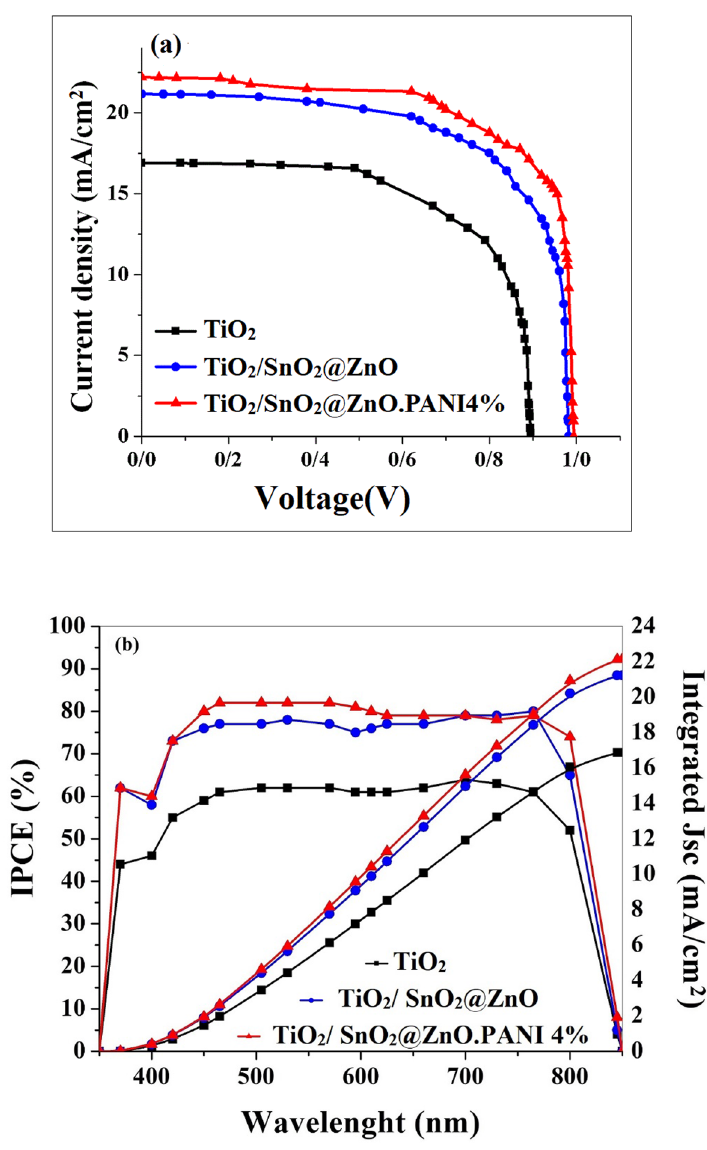
Figure 14. ( a ) The J–V tests of the PSCs from TiO 2 /SnO 2 @ZnO.PANI 4% nanocomposite, TiO 2 /SnO 2 @ZnO/ nanocomposite, and TiO 2 as ETL, and ( b ) The IPCE spectra of different PSCs based on TiO 2 /m-TiO 2 , TiO 2 / SnO